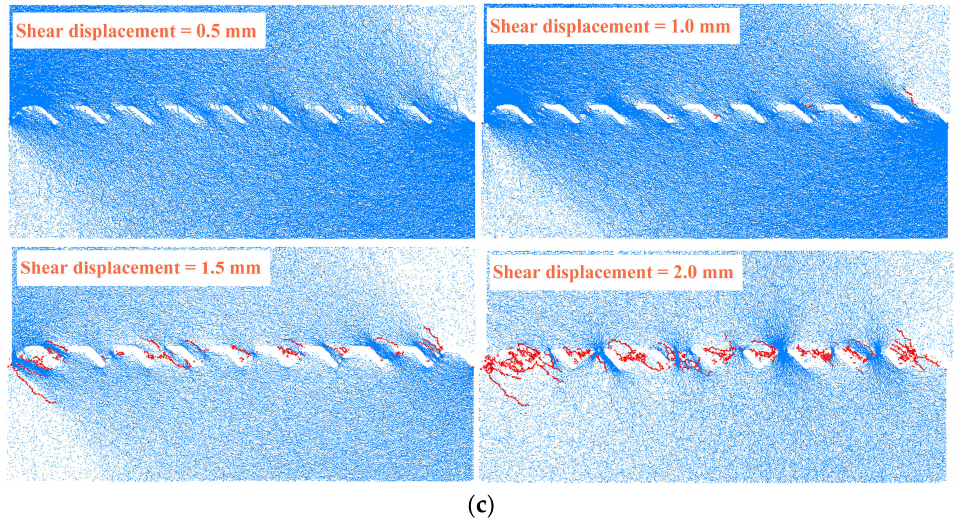
Figure 8. Contact force distribution of samples at different shear displacements: ( a ) roughness r = 0.17; ( b ) roughness r = 0.30; ( c ) roughness r = 0.37.